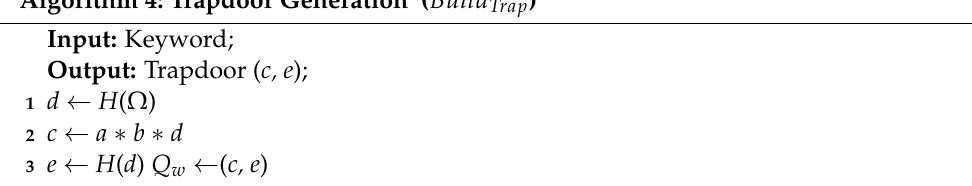
Algorithm 4: Trapdoor Generation ( Build Trap )